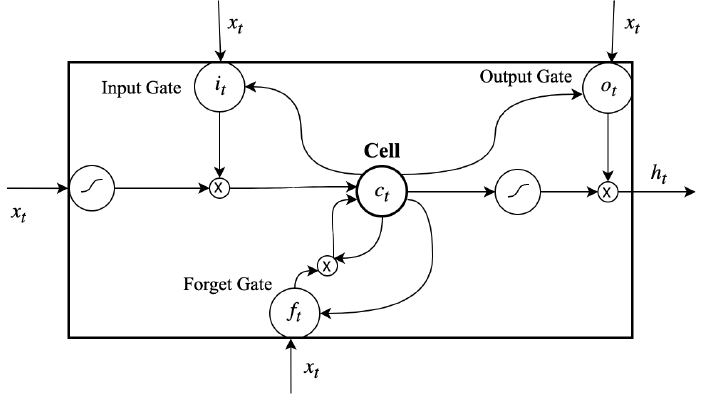
Figure 3. Graphical representation of a long short-term memory